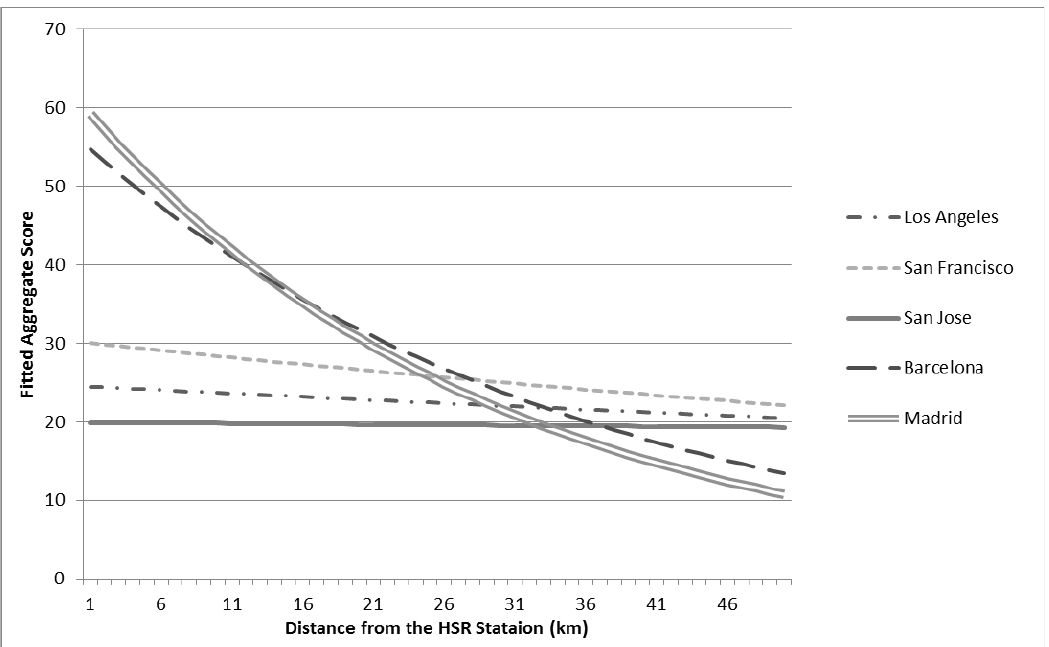
Figure 7 Aggregate Score Gradient for HSR Accessibility of Study